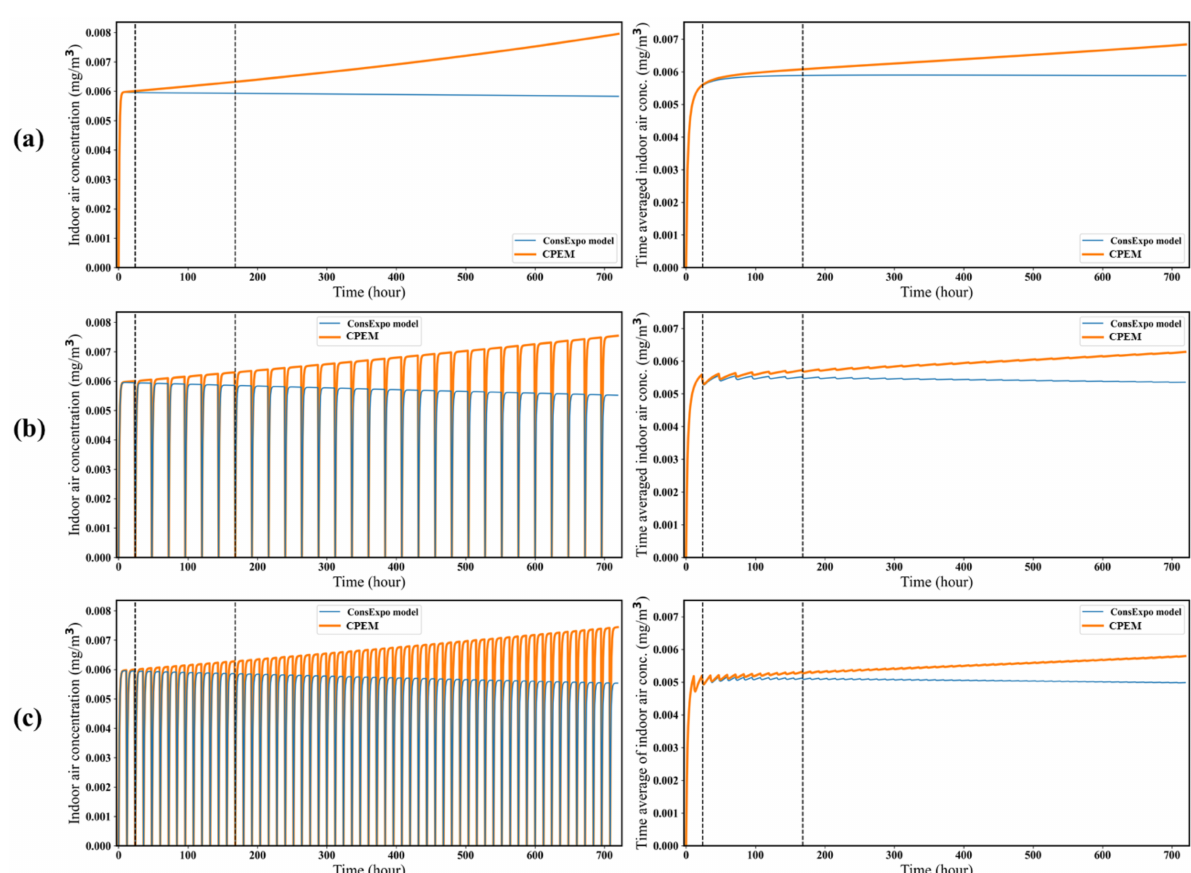
Figure 4. Comparison of the target substance concentrations in the air under different ventilation conditions. The graphs on the left show the air concentrations of the target substance, and the graphs on the right show the time-averaged concentration of target substance in the air over 1 month. The simulation parameters are presented in Table 1. ( a ) No active ventilation, ( b ) active ventilation once a day, and ( c ) active ventilation twice a